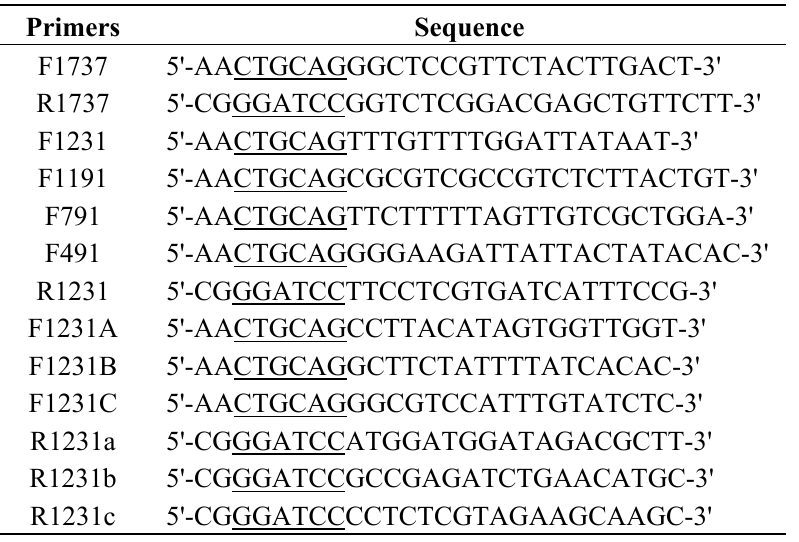
Table 1. The sequence of the primers used in the